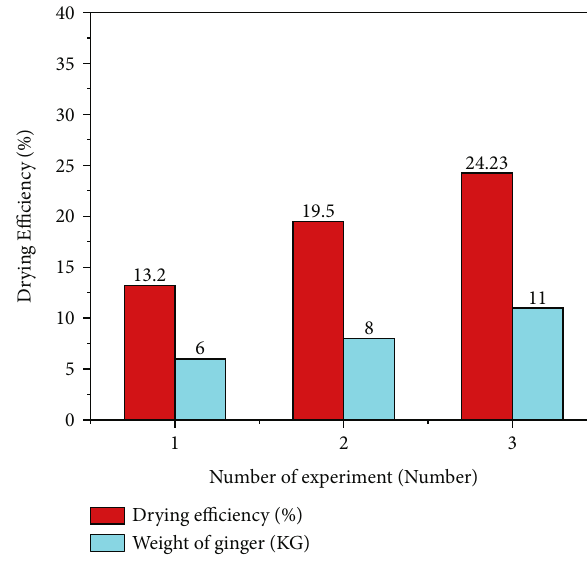
Figure 10: The drying curves for open sun drying and solar tunnel drying at a 11m 2 drying area. Figure 11: Drying e ffi ciency (per mass) of